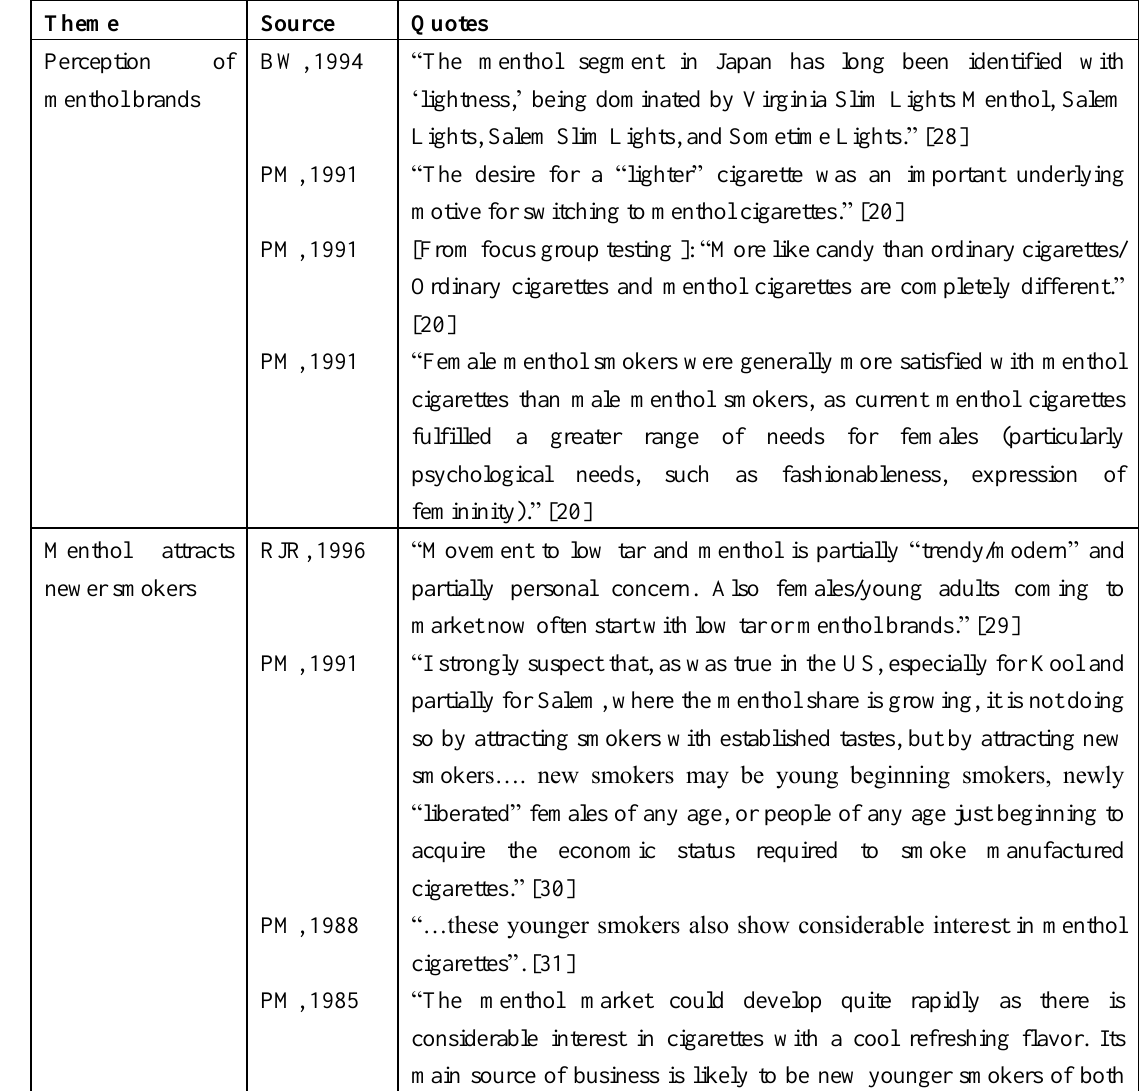
Table 1. Quotes from internal tobacco industry documents describing the potential appeal of menthol brands and targeting of young women (data from